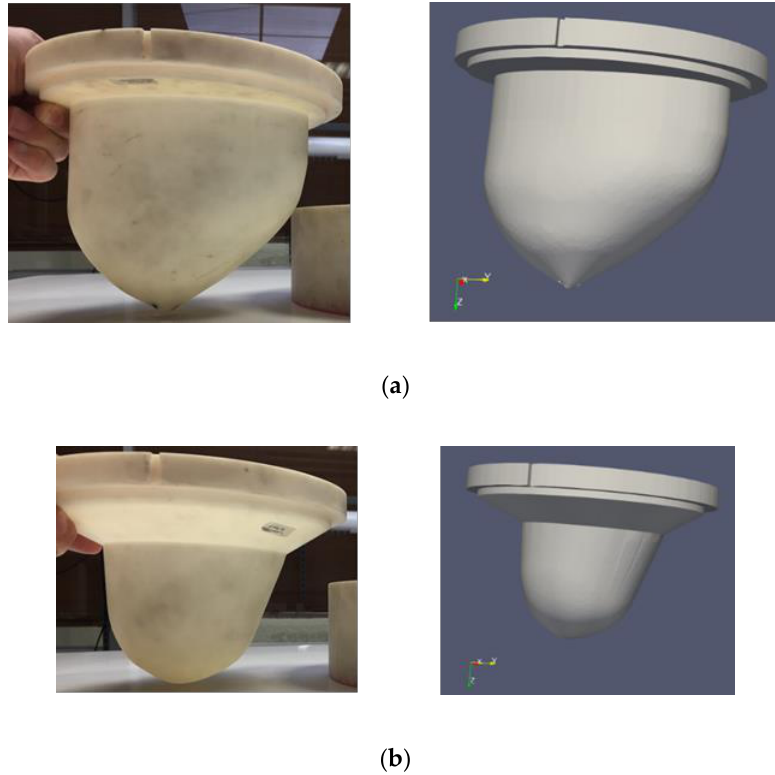
Figure 27. MRI-based 3D printed breast phantoms and their 3D representations: ( a ) Test breast phantom B1; ( b ) Test breast phantom B2.